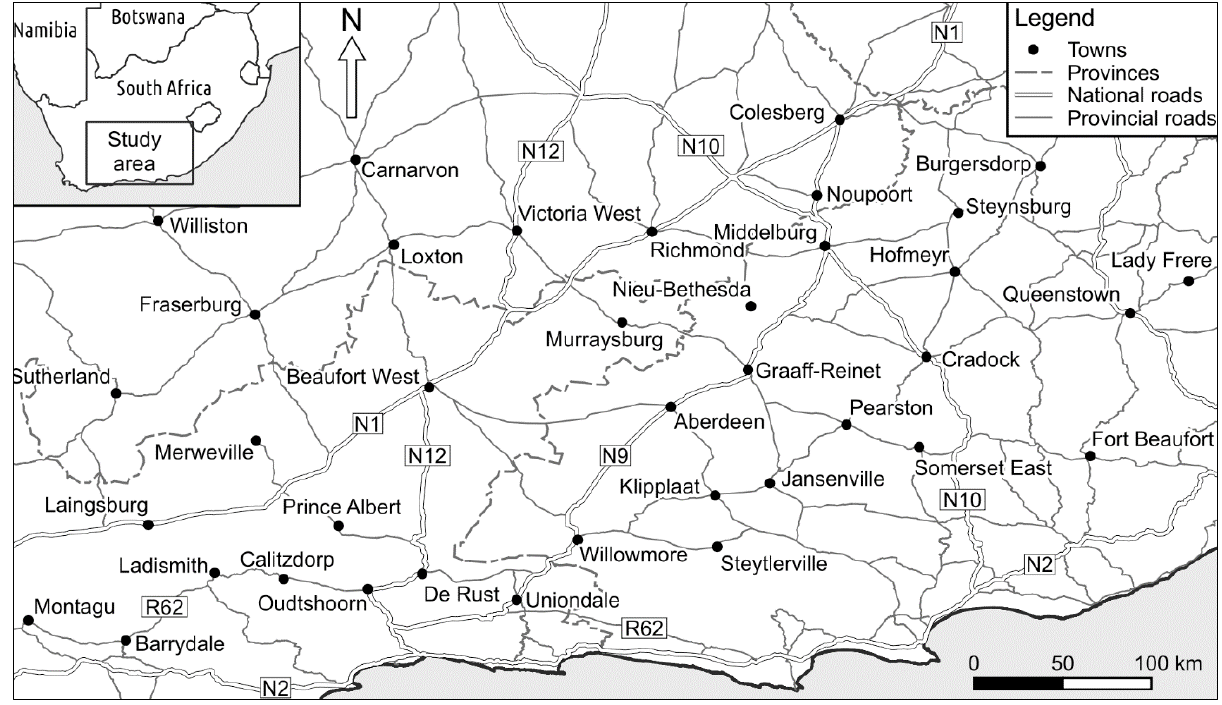
Figure 1: Map showing the towns selected for this